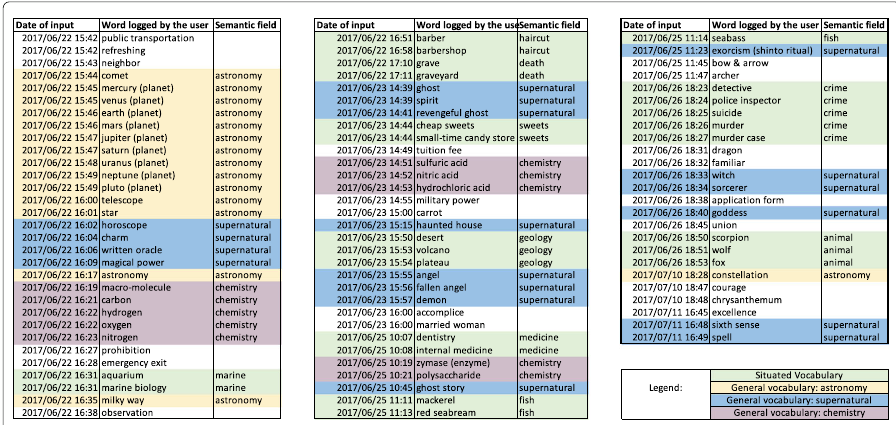
Fig. 3 General and situated vocabulary in the vocabulary of a SCROLL